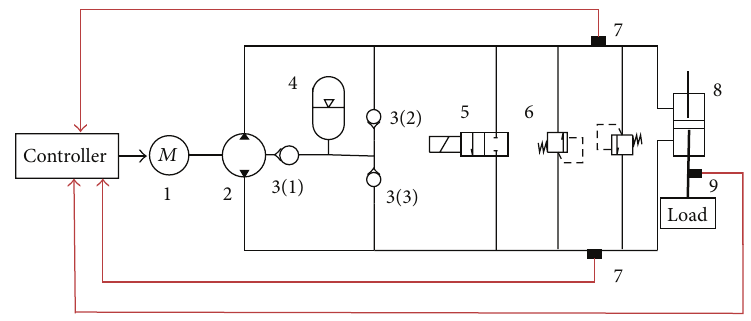
Figure 1: Schematic diagram of